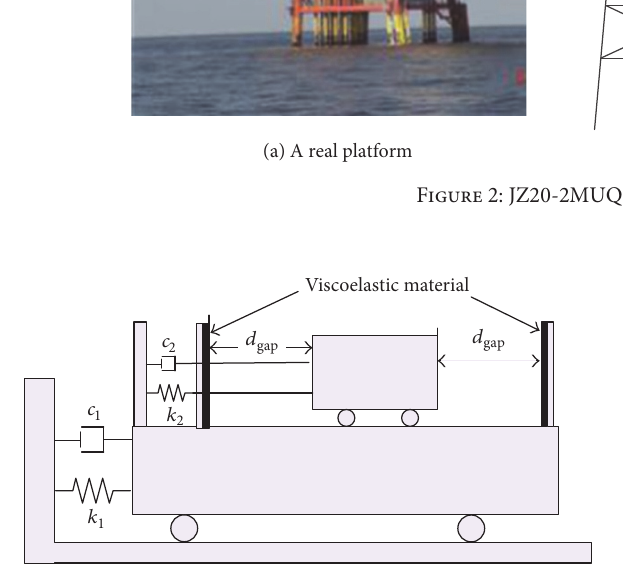
Figure 3: Schematic of a SDOF structure controlled by